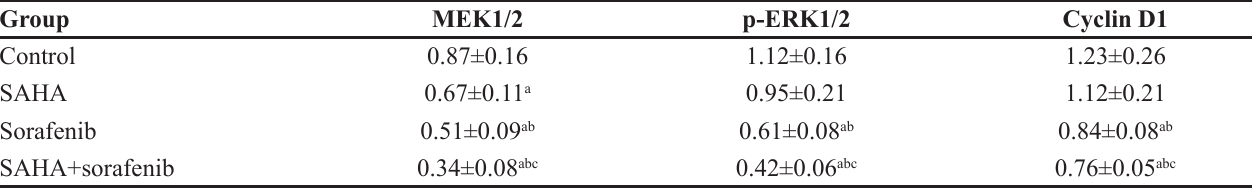
TABLE III - Expression of MEK1/2, p-ERK1/2 and Cyclin D1 protein in xenograft tissue (relative to β-actin)